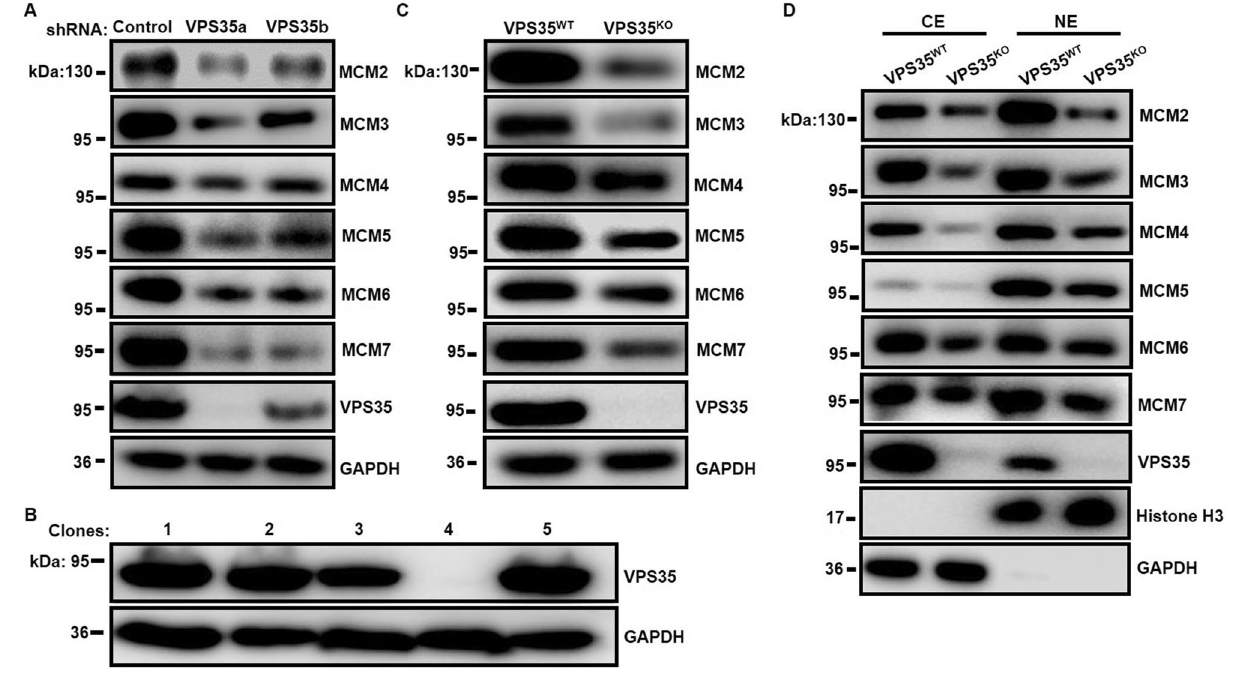
Figure 3. Determination of MCM2-7 protein expression by western blotting. ( A ) Expression of MCM proteins was detected in HeLa cells stably expressing the indicated shRNA. ( B ) VPS35 knockout cells were verified by western blotting, and representative blots are shown. ( C ) Expression of MCM proteins was detected in wild-type VPS35 (VPS35 WT ) and VPS35 knockout (VPS35 KO ) HeLa cells. ( D ) The cytosolic (CE) and nuclear extracts (NE) of VPS35 WT and VPS35 KO HeLa cells were analyzed.